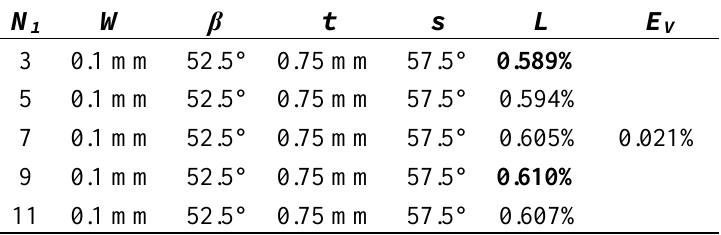
Table 4. Nonlinearity errors of the sensors with different coil turn